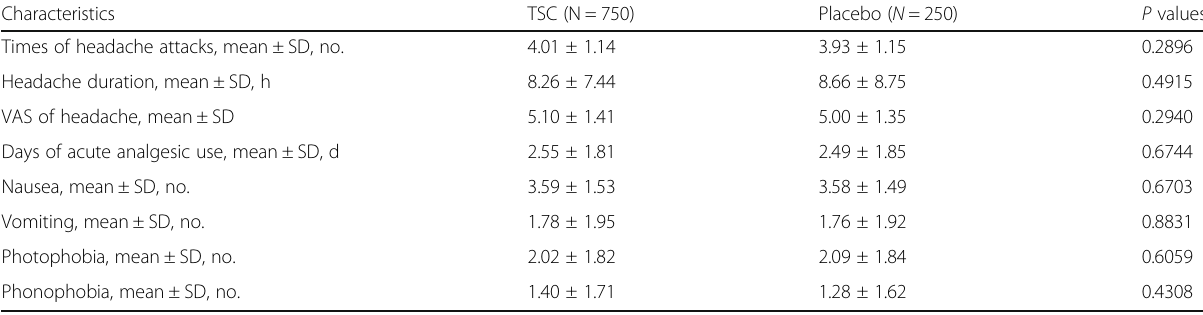
Table 3 Baseline characteristics of efficacy measurements of patients receiving TSC and placebo Characteristics TSC (N = 750) Times of headache attacks, mean ± SD,